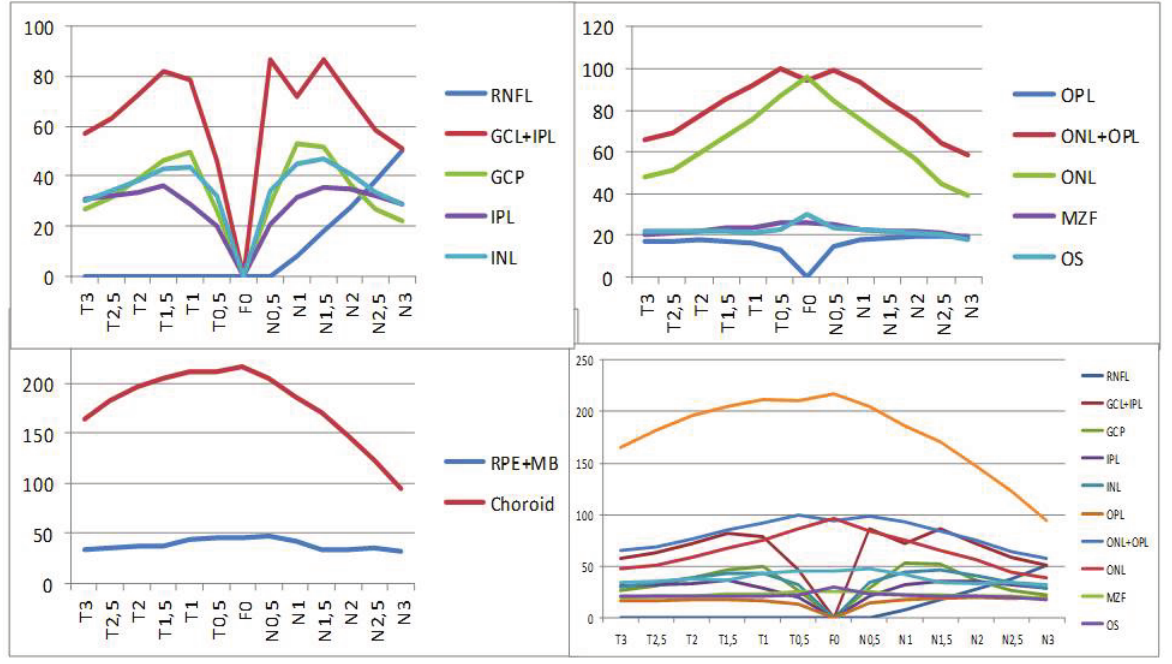
Figure 3. Representation of the 13 locations studied at intervals of approximately 0.5 mm from the center of the fovea. (A) Inner layers. (B) Outer layers. (C) RPE+BM complex and choroid. (D) Total layers in the study. T3, 3 mm temporal; T2.5, 2.5 mm temporal; T2, 2 mm temporal; T1.5, 1.5 mm temporal; T1, 1 mm temporal; F0, foveal thickness; N0.5, 0.5 mm nasal; N1, nasal 1 mm; N1.5, 1.5 mm nasal; nasal N2, 2 mm; N2.5, 2.5 mm nasal; N3, 3 mm